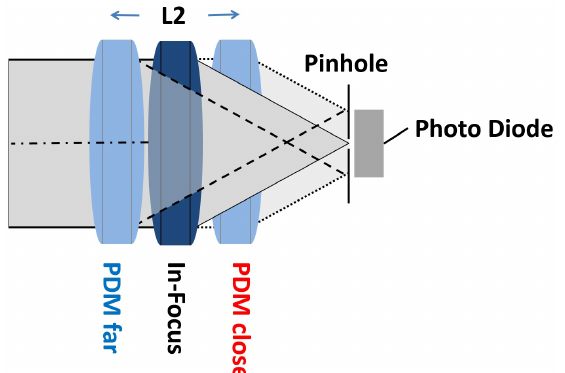
Figure 1. Schematic figure of the pinhole displacement, with L2 lens in front of the pinhole and detector of the confocal